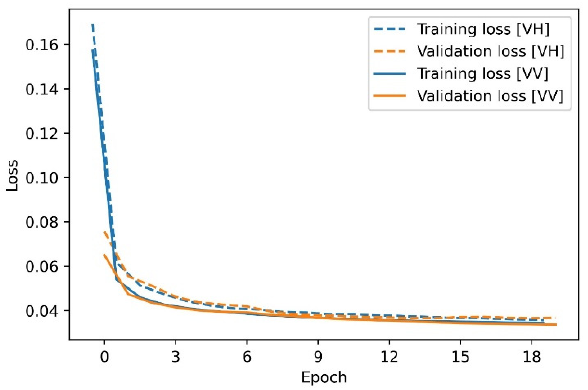
Figure 6. Mean Squared Error loss over iterations (Epochs) for ConvLSTM model.